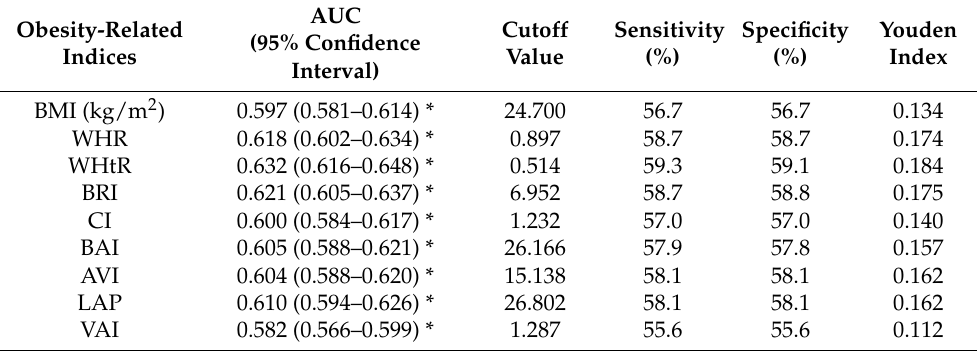
Table 6. Area under curve (AUC), cutoff value, sensitivity, specificity, and Youden index of nine obesity-related indices in male